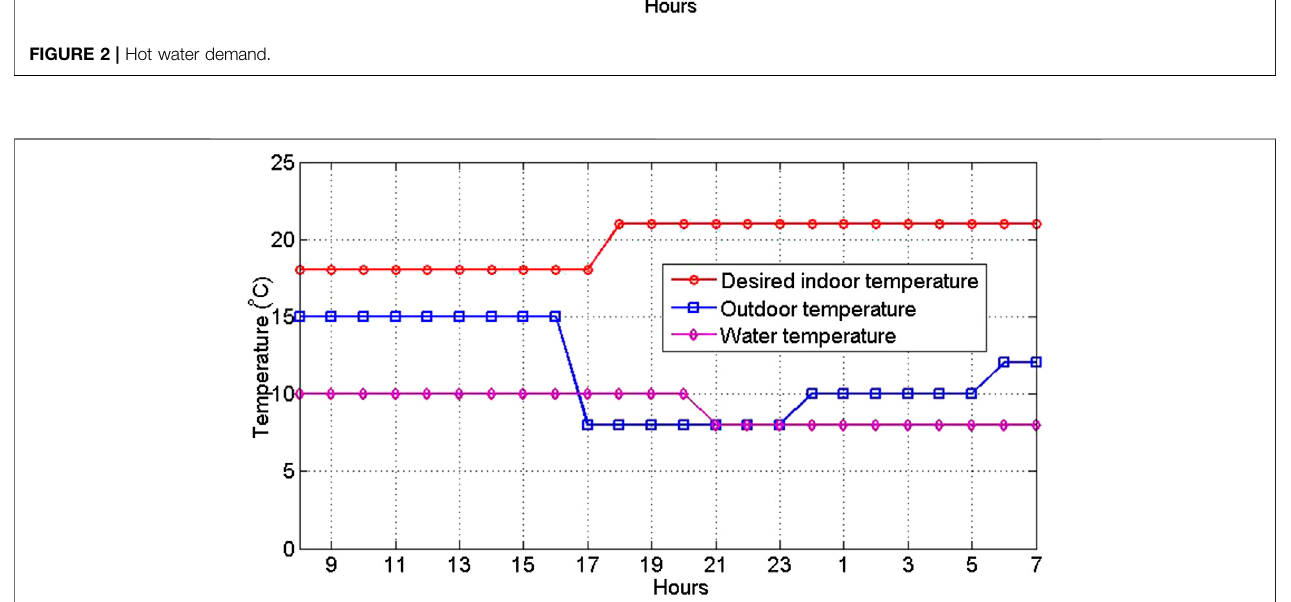
FIGURE 3 | Desired, outdoor and cold water temperatures.